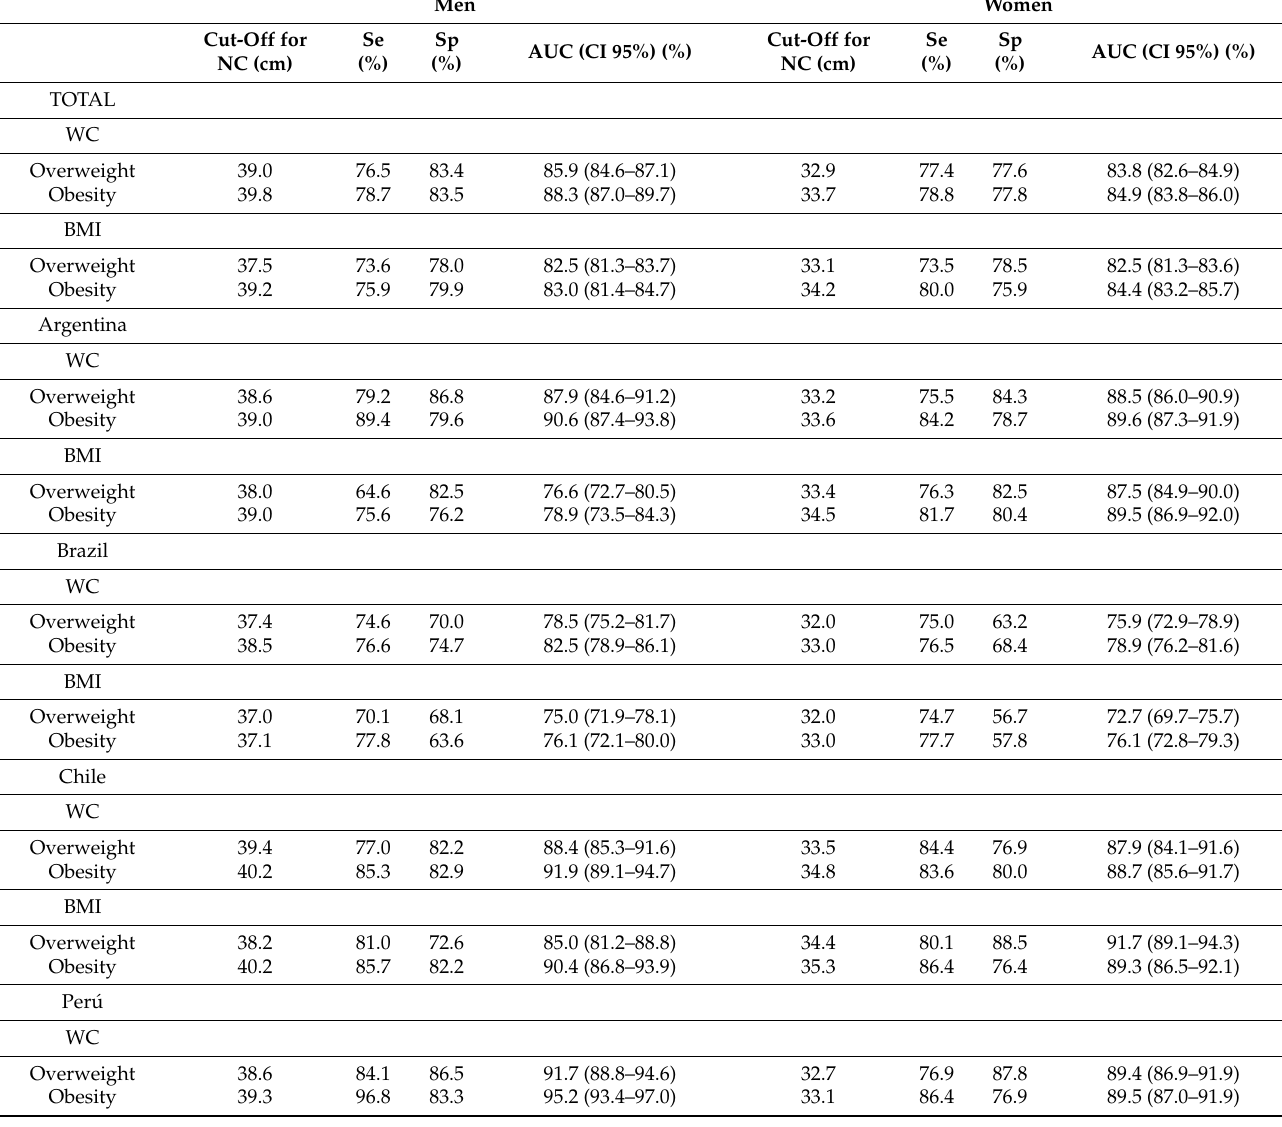
77.4%, Sp: 77.6%). For obesity compared to WC, the AUC was 88.3 (CI 95% = 87.0–89.7) for the cut-off point of 39.8 cm (Se: 78.7%, Sp: 83.5%), and, in women, the AUC was 83.8 (CI 95% = 82.6–84.9), for the cut-off point of 33.7 cm (Se: 78.7%, Sp: 83.5%). Most countries showed very similar values, and Brazil showed the lowest cut-off points for both overweight and obesity in men and women (overweight: 37.4 cm in men and 32.0 cm in women and obesity: 38.5 cm in men and 32.9 cm in women). The AUC when compared with overweight and obesity values according to BMI are lower and the cut-off points are also lower. Thus, in the total population, the AUC for overweight in men is 82.5 (CI 95%: 81.3–83.7) for the cut-off point of 37.5 cm (Se: 73.6% and Sp: 78.0%) and in women, the AUC is 82.5 (CI 95%: 81.3–83.6) for the cut-off point of 33.1 cm (Se: 73.5% and Sp: 78.5%). In the case of obesity in men, the AUC is 83.0 (CI 95%: 81.4–84.7) for the cut-off point of 39.2 cm (Se: 75.9% and Sp: 79.9%), and, in women, the AUC is 84.4 (CI 95%: 83.2–85.7) for the cut-off point of 34.2 cm (Se: 80.0% and Sp: 75.9%). Table 4. Cut-off for NC, sensibility, specificity, and area under the curve compared by nutritional level of WC and BMI for the total population and by country. Latin American Health and Nutrition Study/Estudio Latino Americano de Nutrici ó n y Salud (ELANS). Men Women Cut-Off for Se Cut-Off for Se Sp AUC (CI 95%) (%) NC (cm) NC (cm) (%) (%)